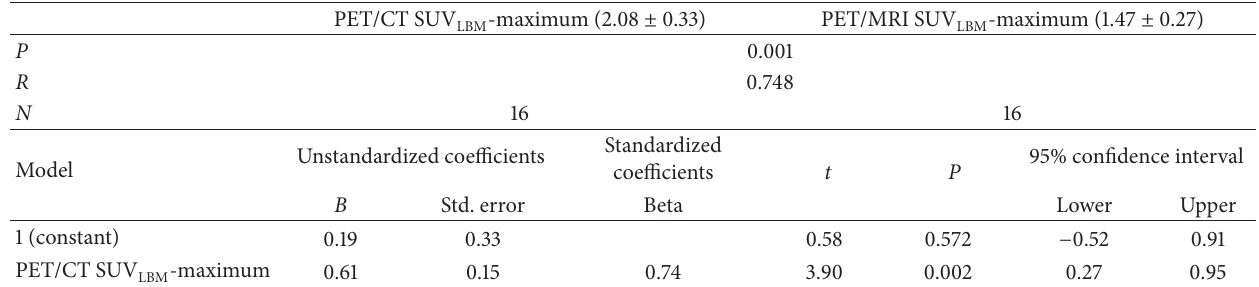
-maximum and PET/MRI SUV LBM